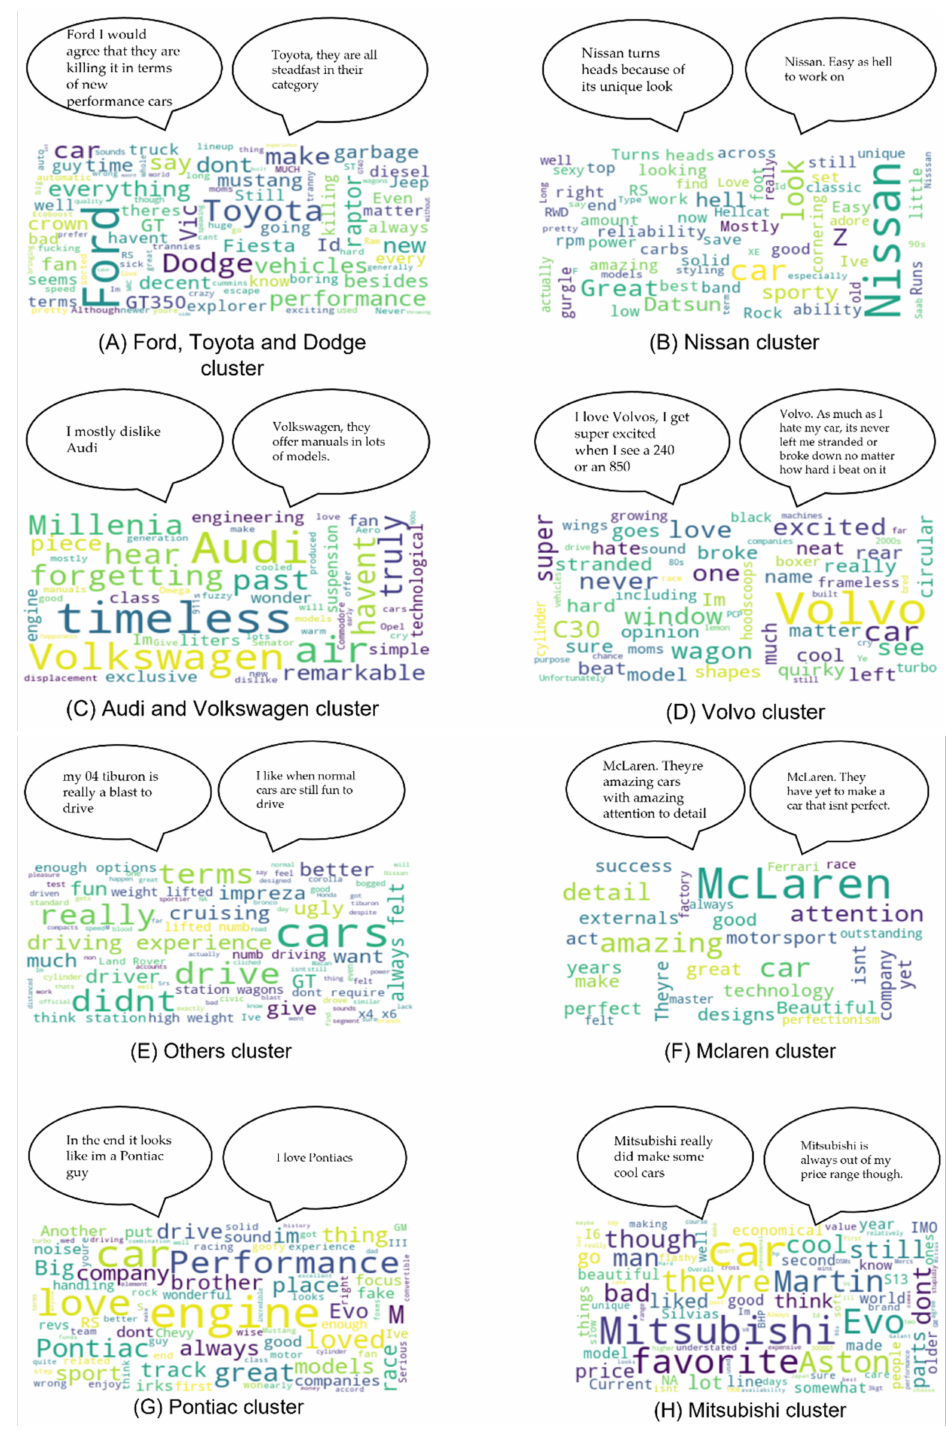
Figure 11. Word clouds with the remaining clusters results of the car brands